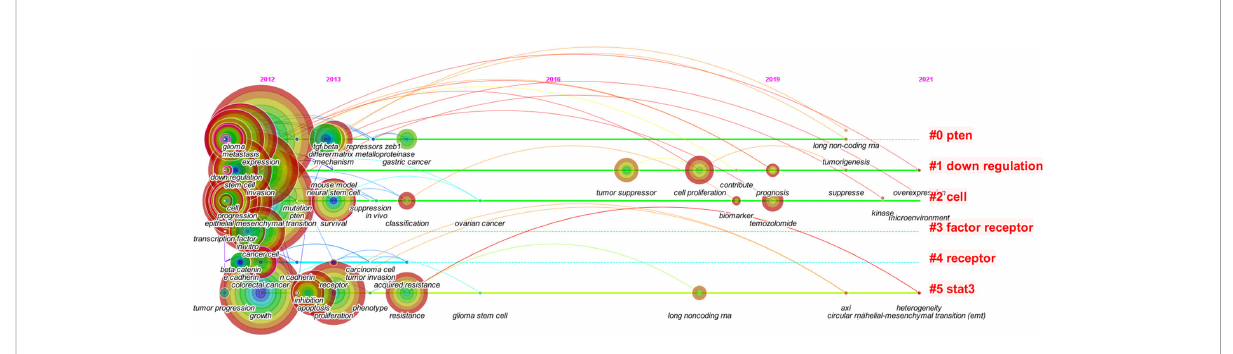
FIGURE 5 The timeline view of keywords in the six main clusters from 2012 to 2021.